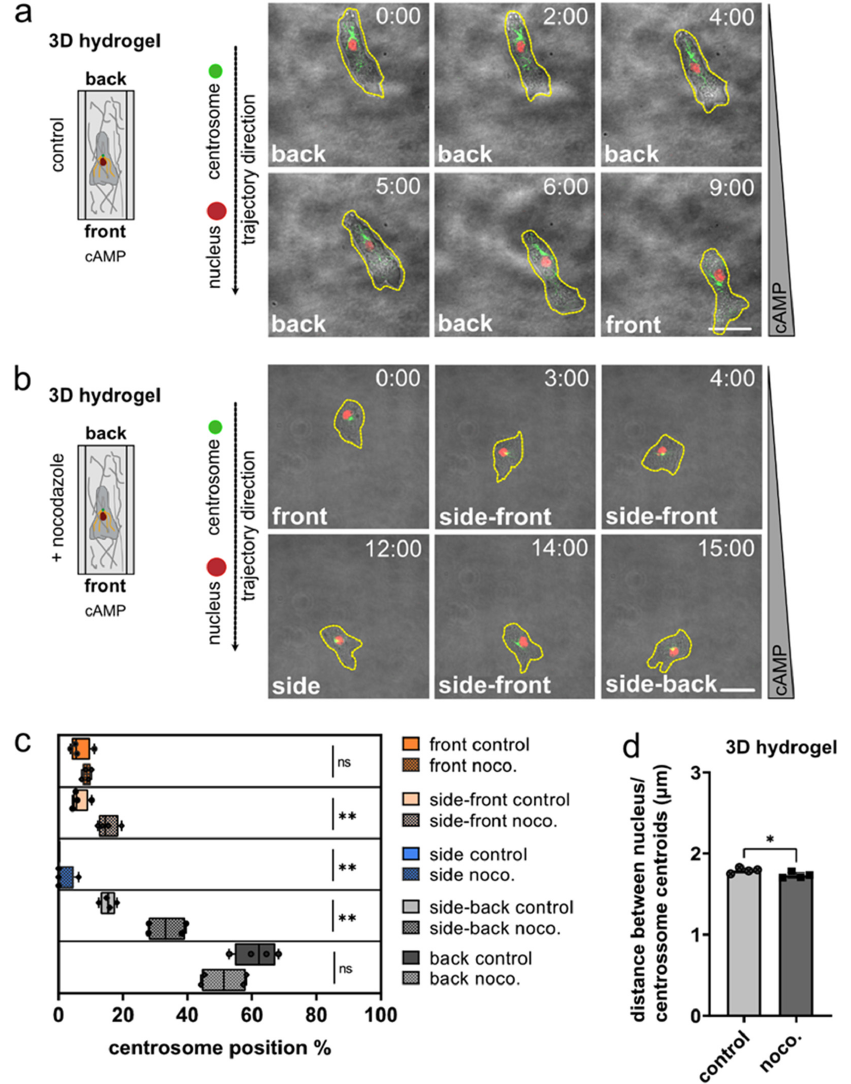
Figure 3. Centrosome positioning in aggregation competent Dictyostelium cells moving chemotactically in 3D environments. ( a , b ) Schemes (left), and representative microscopy images (right) of a Dictyostelium cell migrating in a chemotaxis chamber with a 3D hydrogel matrix. The cells express both the nuclear marker mRFP-histone (red), and GFP-tubulin (green) to highlight centrosomes and microtubules. The cell shape is marked by a yellow dashed line. Images were taken with 10 s-frame intervals. Time is indicated in min and s at the top. N = 4, number of cells = 40 for control; N = 4, number of cells = 40 for nocodazole. ( c ) Analysis of the position of the centrosome in Dictyostelium cells moving chemotactically in 3D hydrogels. Note that there were no events for side control. ( d ) After nocodazole treatment, in cells moving chemotactically in 3D the distance between the centroid of the nucleus and the centroid of the centrosome was slightly decreased. Scale bars are 10 µm. * P < 0.05, **P < 0.01 are considered significant, and ns = not significant.